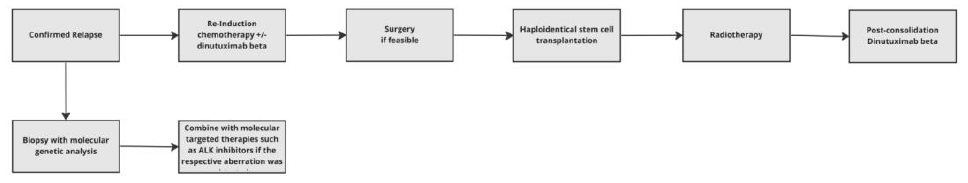
Figure 1. Flow diagram of our interdisciplinary standard of care for relapsed neuroblastoma.